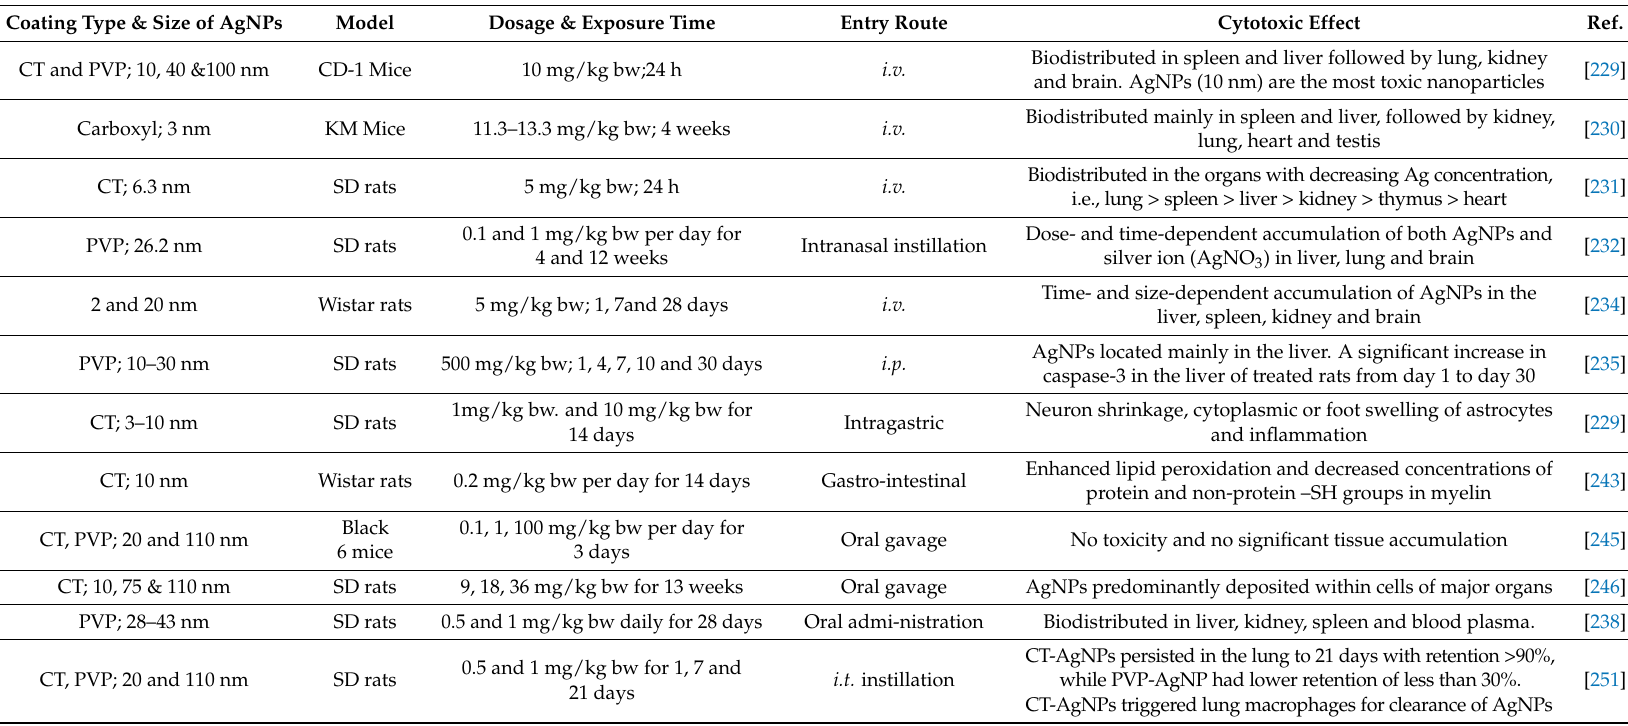
Table 3. Recent in vivo studies showing biodistribution and toxicity of AgNPs in rodents through different administration